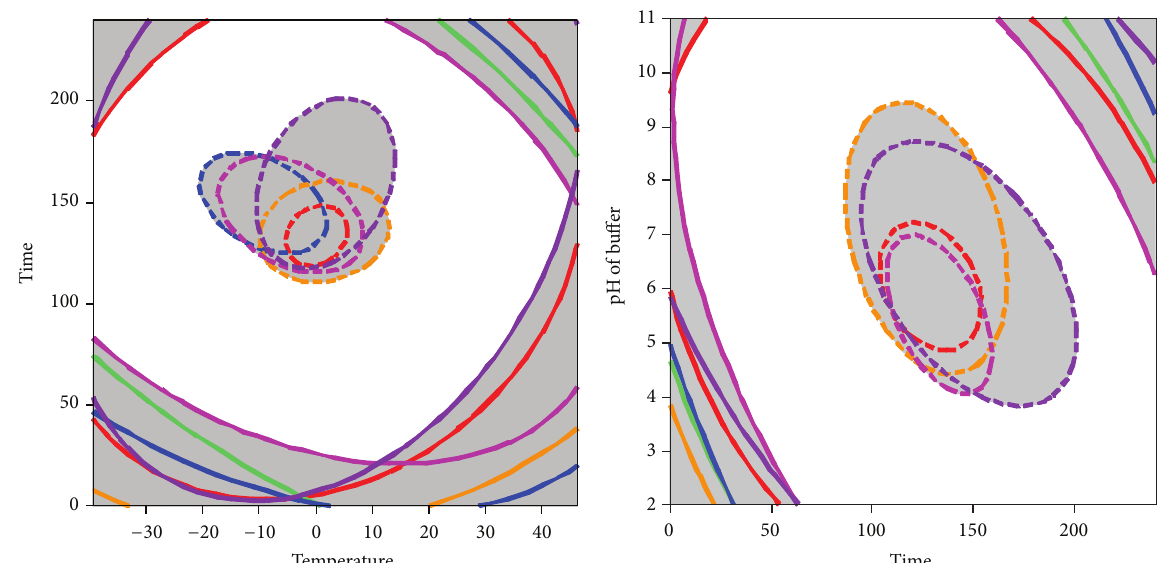
(a) Overlaid contour plot of amylase acti, storage stability, and pH stability.